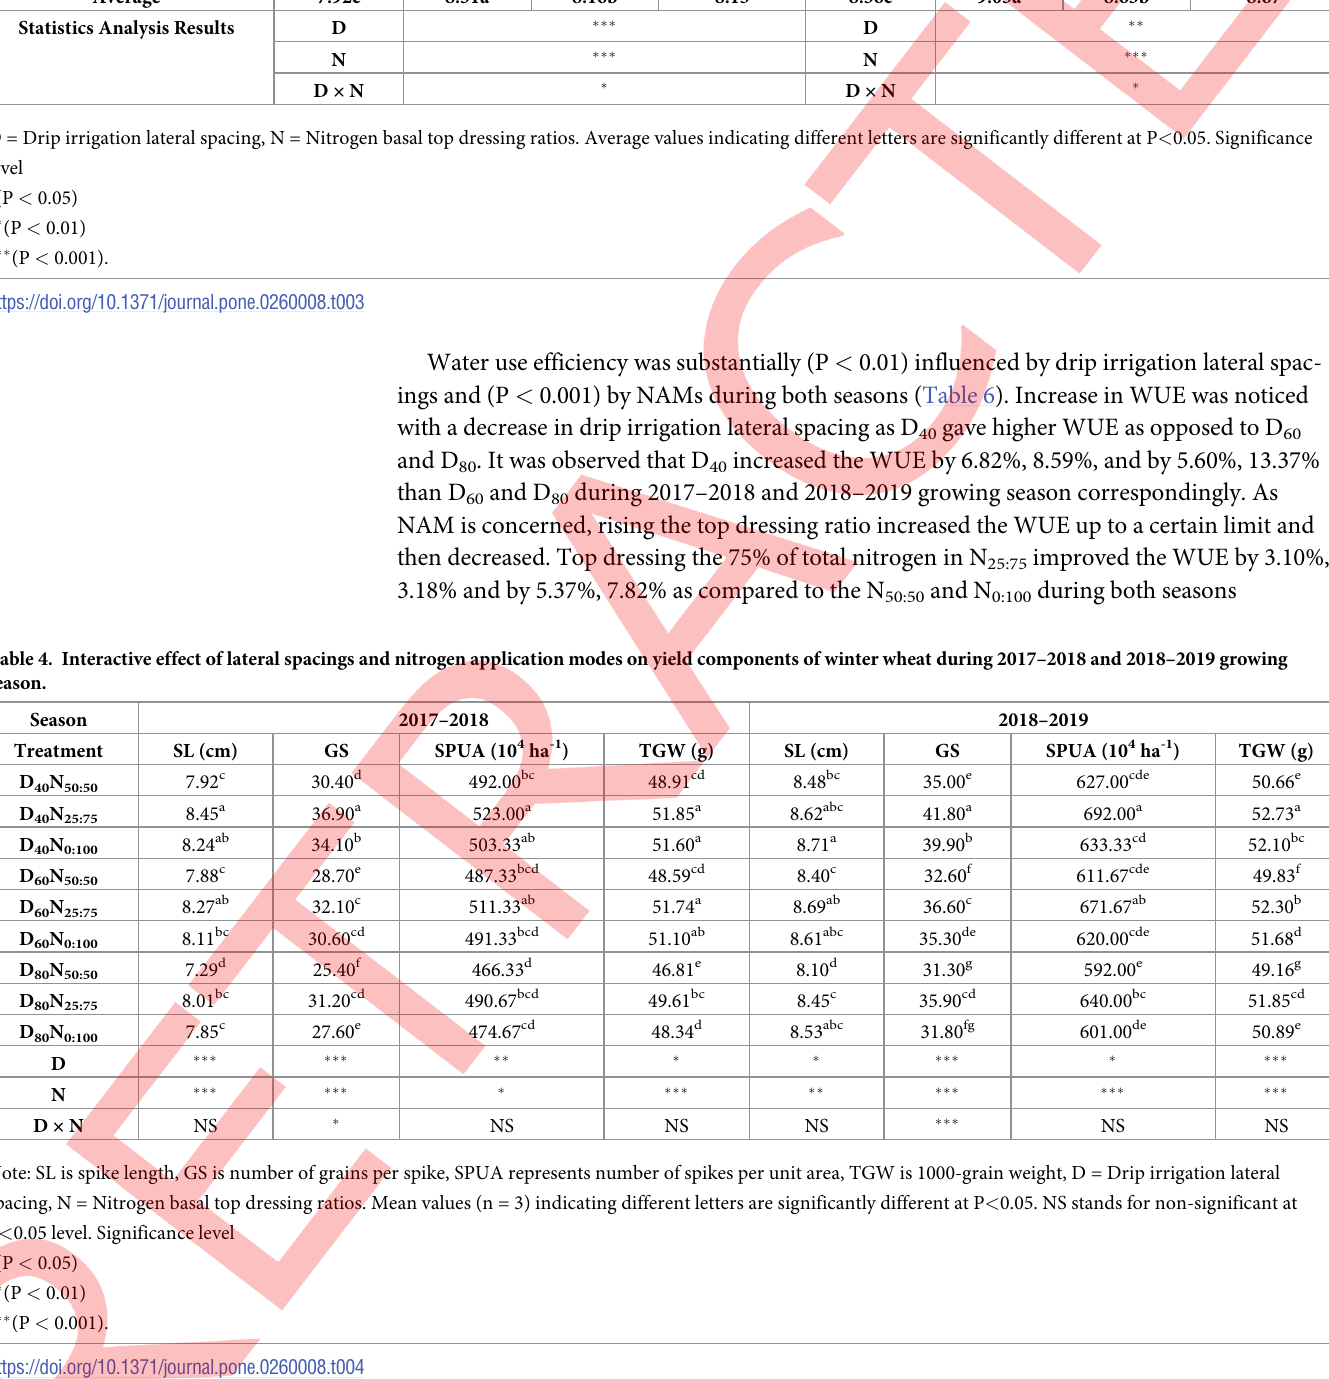
Average Statistics Analysis Results